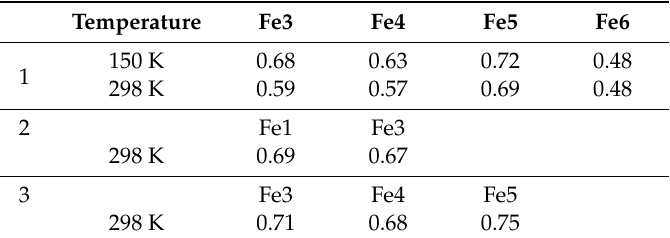
Figure 1. Structure illustrations of 1 : coordination geometries of the pentanuclear cation ( a ) and binuclear anion ( b ) and tetramer in the structure of 1 ( c ). Table 2. The values of trigonality index τ for 1 , 2, and 3 .